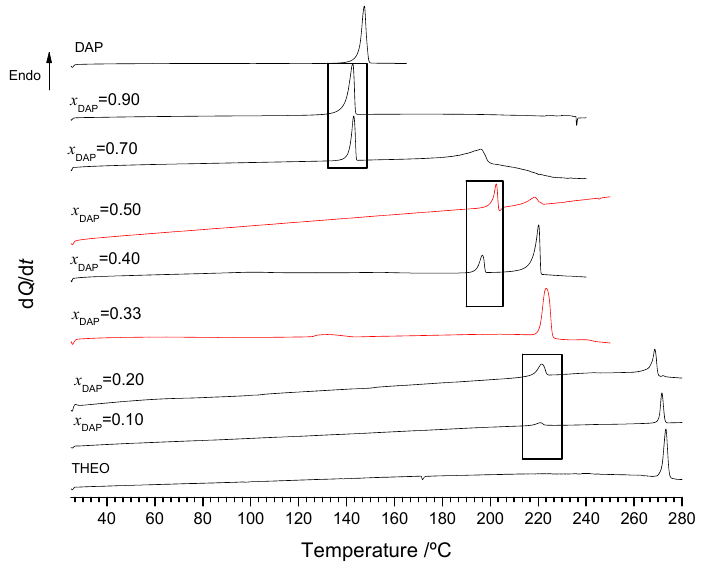
Figure 4. Representative DSC heating curves of DAP + THEO mixtures of different DAP mole fractions, x DAP , prepared by LAG, ethanol-assisted. β = 10 °C/min −1.